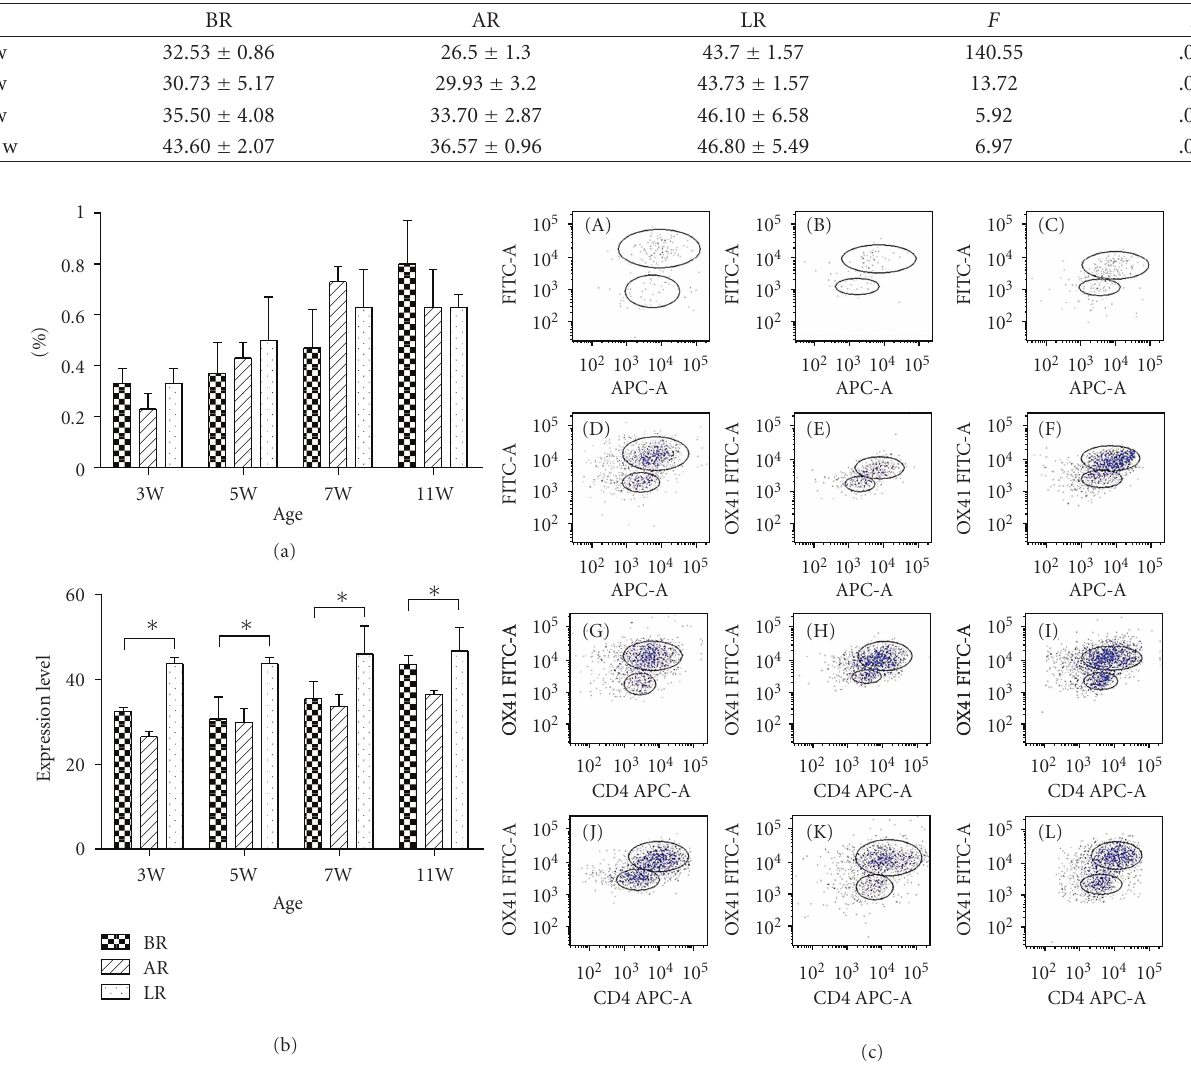
Figure 1: The expression of OX62 + DCs and OX62 + CD4 + SIRP + DCs of each groups at various development stages (Mean ± SD). (a) The expression level of OX62 + DCs of each group at di ff erent stages. (b) The expression level of OX62 + CD4 + SIRP + DCs of each group at di ff erent stages. (c) Single-cell suspensions of the total PP-DCs in rats were identified by OX62. The di ff erence of OX62 + DC among groups at di ff erent development stages was not significant. ( F = 3.0, 0.587, 3.267, and 1.471, resp.; P > . 05). Significant growth occurred in LR group for the number of OX62 + CD4 + SIRP + DCs at age week 3. Levels of OX62 + CD4 + SIRP + DC subsets at every age were highly significant in LR group and BR group compared with AR group. Furthermore, the positive cell numbers were higher in LR group than in BR group. The positive cell numbers kept stable in LR group at various ages while the positive cells number increased with age in the other two groups. Significant numbers of OX62 + CD4 + SIRP + DCs were found in LR and BR group at various ages (Figures 1(b) and 1(c)) compared with AR group (A: BR at W3, B: AR at W3, C: LR at W3, D: BR at W5, E: AR at W5, F: LR at W5, G: BR at W7, H: AR at W7, I: LR at W7, J: BR at W11, K: AR at W11, L: LR at W11). ∗ P < .